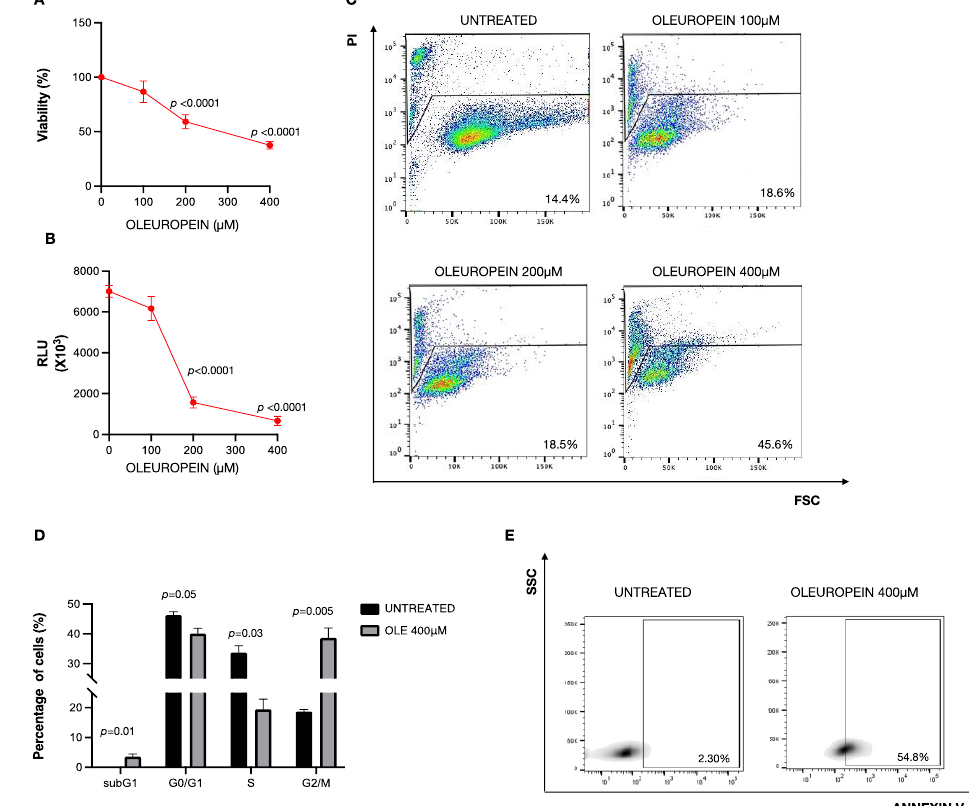
Figure 1. A high dose of oleuropein inhibits cell survival by increasing apoptosis. HEY cell viability and mortality were measured after 24 h of OLE treatment at the concentrations indicated in the figure by Trypan Blue dye exclusion ( A ), Cell Titer-Glo Luminescent cell viability assay ( B ), and by Propidium Iodide (PI) staining ( C ). ( D ) A bar diagram of the number of cells in each phase of the cell cycle based on PI staining and ( E ) representative density plot of Annexin V binding assay of in vitro-cultured untreated and treated HEY cells with OLE (400 μ M) analyzed by flow cytometry. Values (mean ± SEM; n = 3) are shown. Statistically significant difference was determined by Student’s t